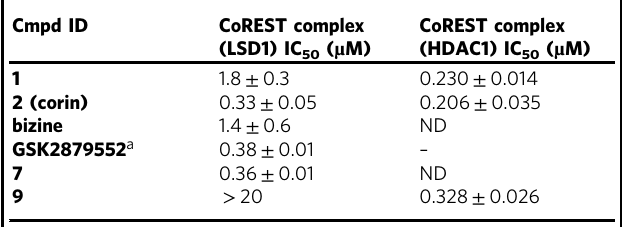
Table 2 Biochemical characterization of dual inhibitors against LSD1 and HDAC1 as part of the CoREST ternary